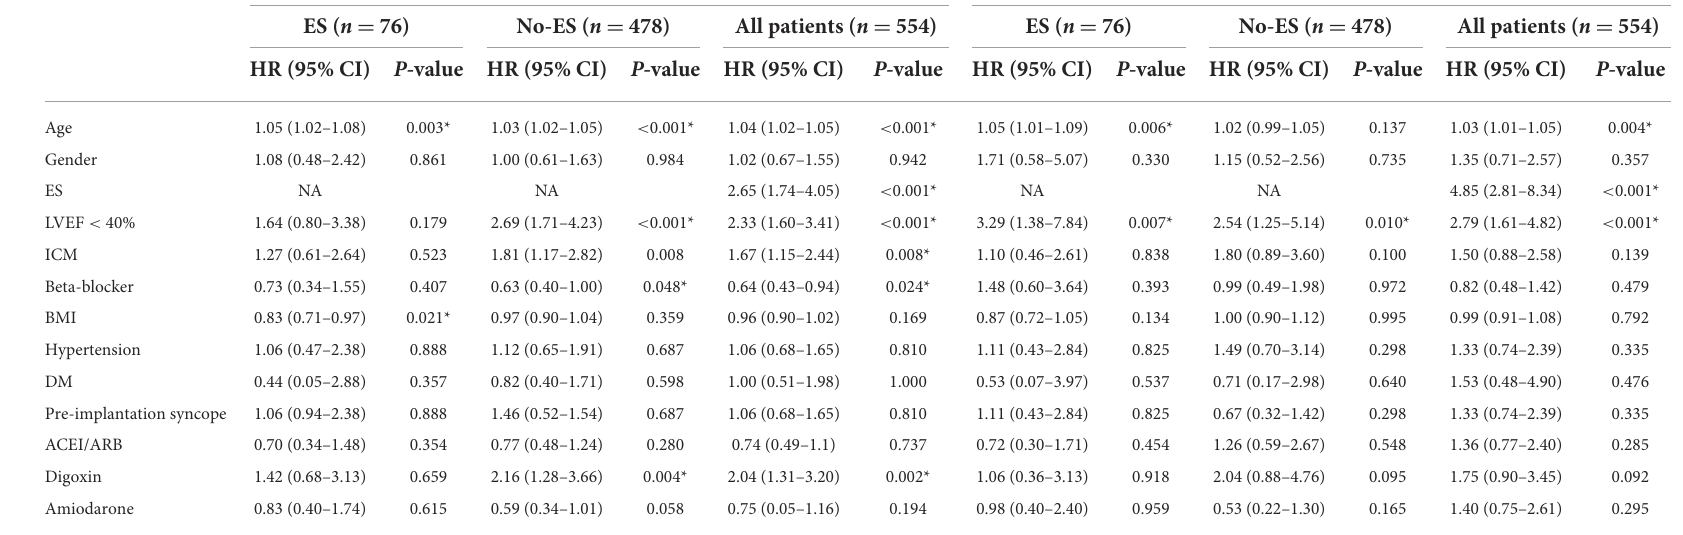
TABLE 3 Univariable cox regression hazard ratios for all-cause and cardiovascular